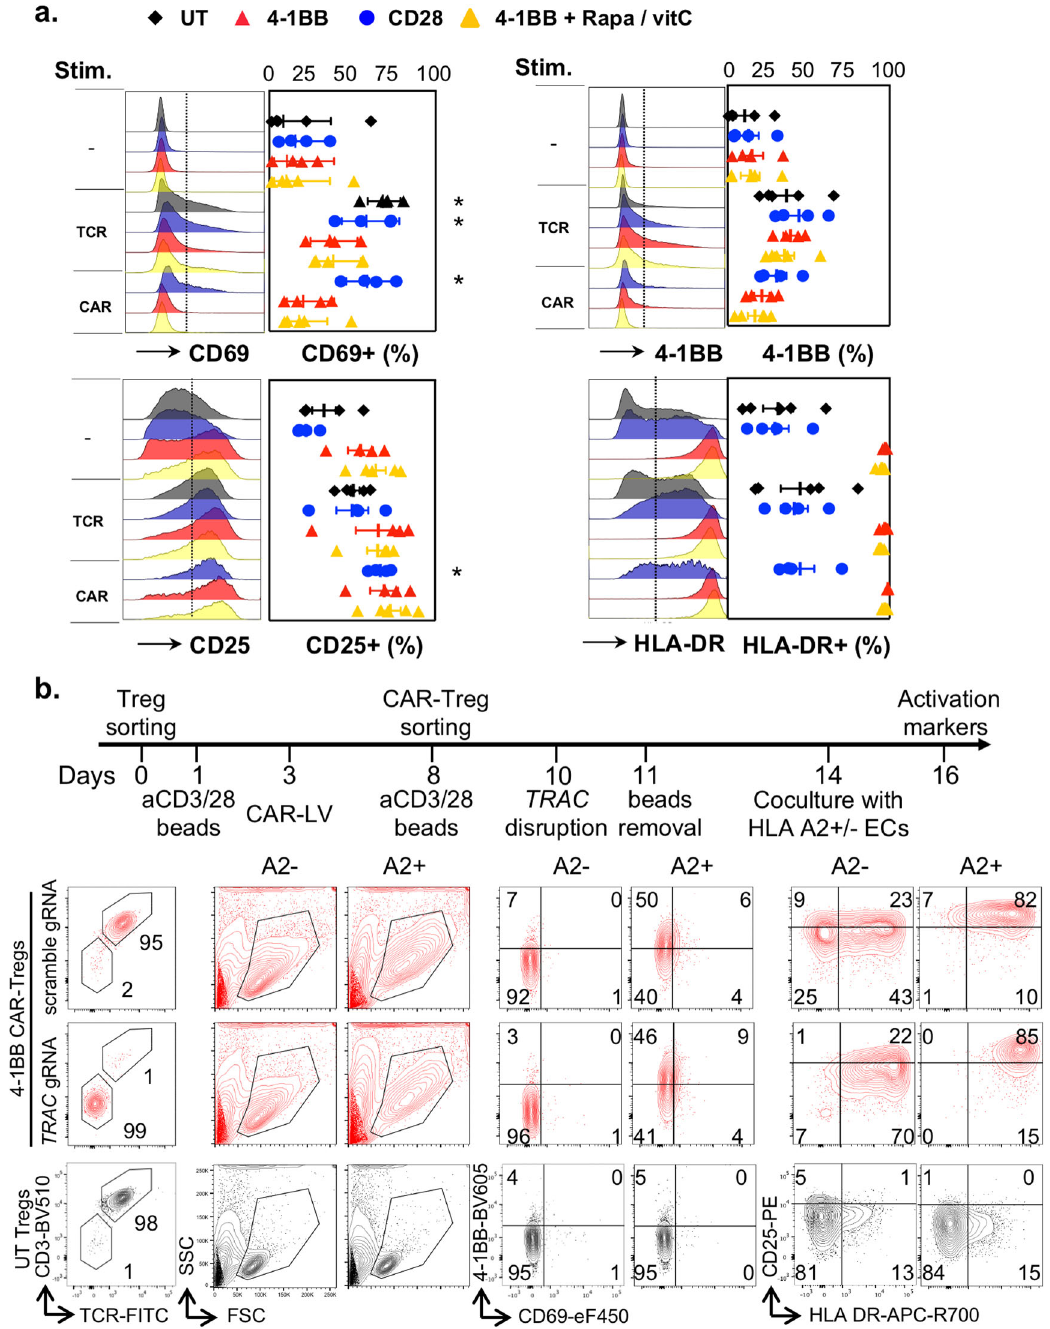
Fig. 8 4-1BB tonic signaling reduces the ability of CAR-Tregs to be stimulated. a Tregs were transduced and expanded as shown in Fig. 1c. On day 16, cells were stimulated overnight with either plate-bound HLA-A2 pentamers (CAR) or anti-CD3/CD28 beads (TCR) before fl ow-cytometry analysis. Representative histograms of each activation marker (left panels) and the frequencies of positive cells (right panels) before and after stimulation are shown. N = 5 donors from fi ve independent experiments. The mean + / − SEM is represented. Two-tailed Mann – Whitney tests were performed to compare unstimulated and stimulated (either via the TCR/CD3 complex or CAR) cells transduced with the same CAR construct. * p < 0.05. Statistically signi fi cant induction of CD69 marker is found in CD3/CD28-stimulated unstransduced (UT) Tregs ( p = 0.0159), CD3/CD28-stimulated ( p = 0.0286), and CAR-stimulated ( p = 0.0286) CD28 CAR-Tregs. Similarly, CAR stimulation signi fi cantly increases the expression of CD25 by CD28 CAR-Tregs ( p = 0.0286). b TCR-de fi cient or competent 4-1BB CAR-Tregs were produced as shown in the upper panel, TRAC was deleted using CRISPR/cas9 on day 10 of culture before being subsequently activated with HLA-A2 + / + or HLA-A2 − / − endothelial cells on day 14 and assessed for activation marker expression by fl ow cytometry on day 16. Contour plots representative of two independent experiments ( n = 2 donors) show the expression of the indicated markers for TRAC -deleted 4-1BB CAR-Tregs, scrambled gRNA-negative control 4-1BB CAR-Tregs and UT Tregs (lower